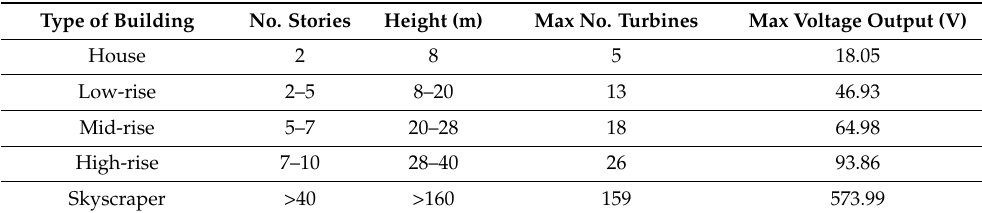
Table 5. Power generation of multiple turbines.